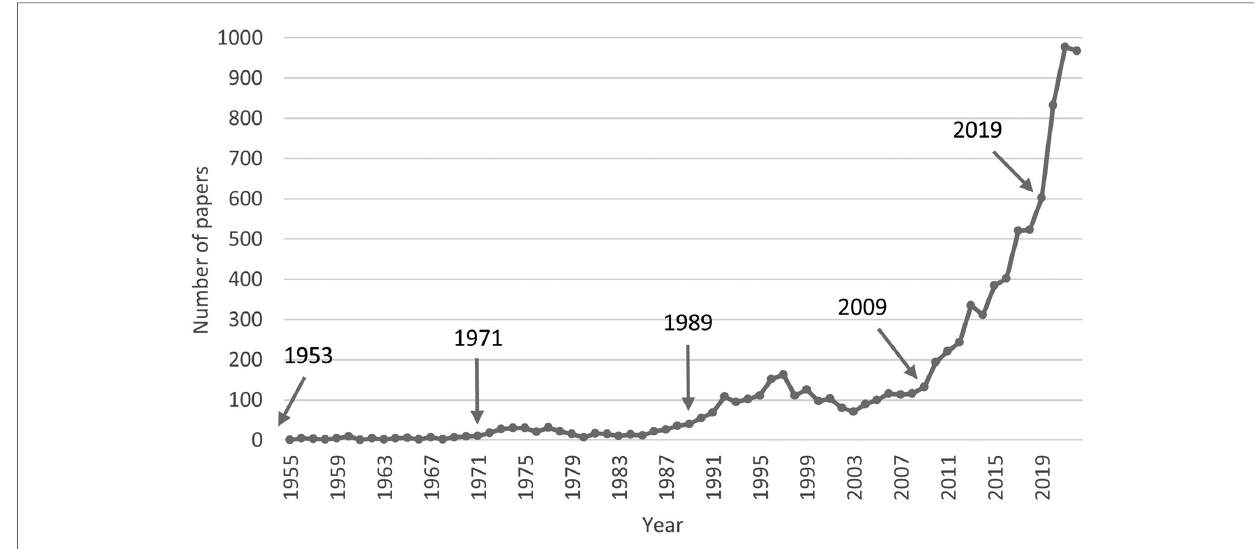
FIGURE 2 Chronological distribution of ECMO research papers.